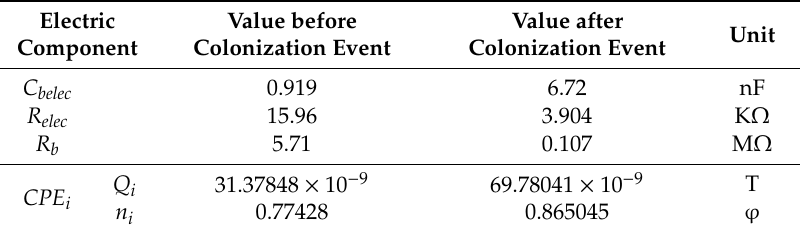
Table 1. Average values of the simplified equivalent